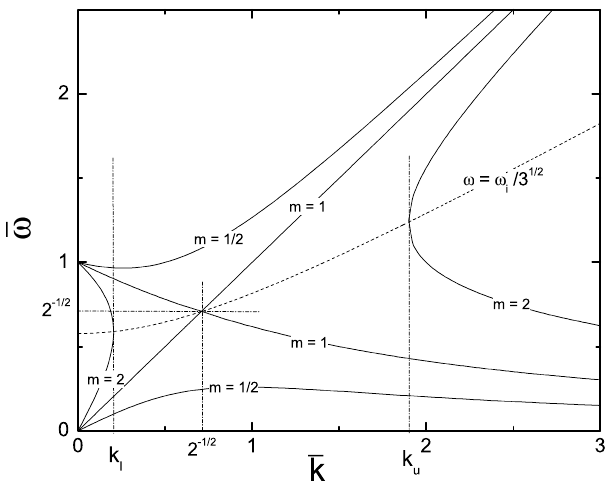
Fig. 1. The diagnostic diagram, ( ω , k ) plot, for the coupled modes, including a stable case ( m = 1 / 2), an unstable case ( m = 2), and the critical case ( m = 1). The higher frequency curve segments (above √ 3) describe the gravity-inertial mode, and the the locus ω = ω i / lower frequency segments the Rossby mode. The coupling of these modes leads to a convective instability for m>